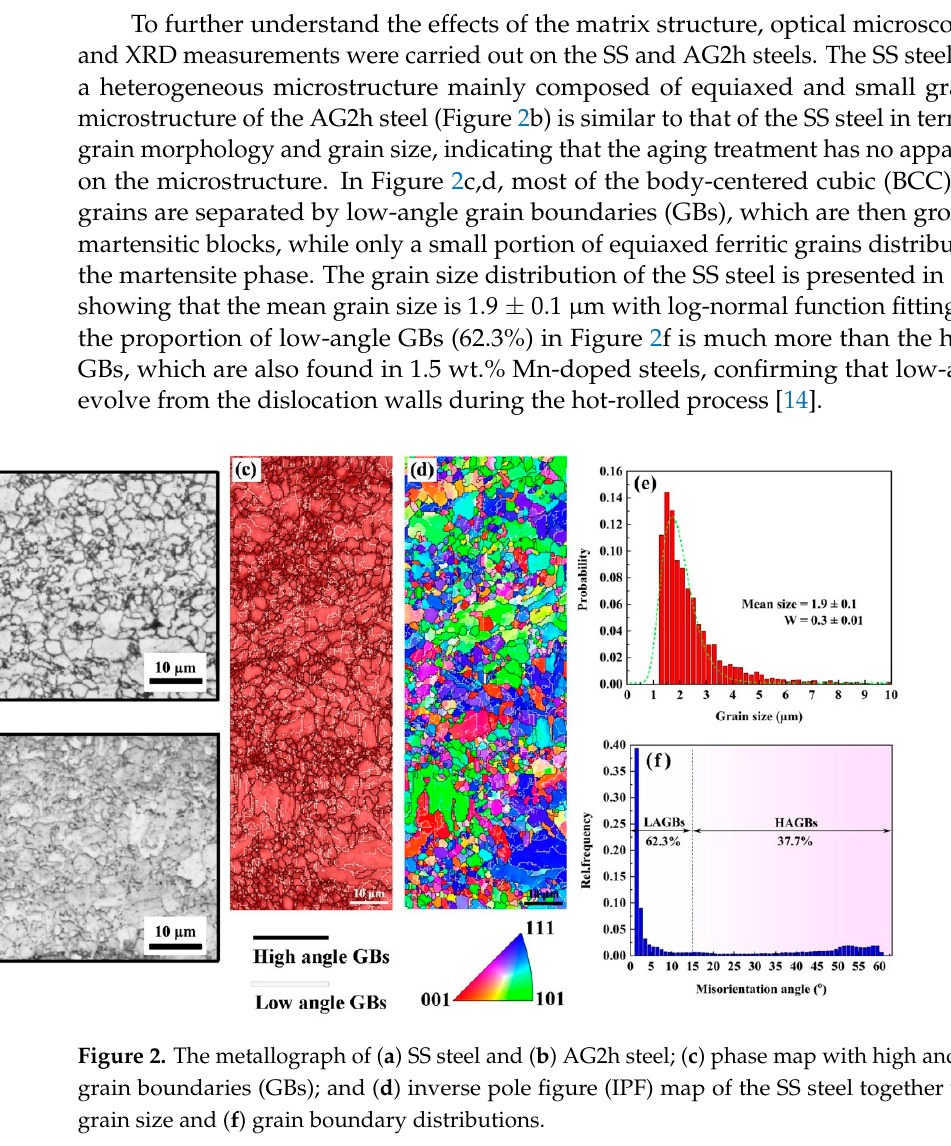
Table 2. Mechanical properties of the nanoprecipitate-strengthened steels with different Mn contents. Yield Strength (MPa) Strength Martrix Microstructure Solid Solution Peak Aging